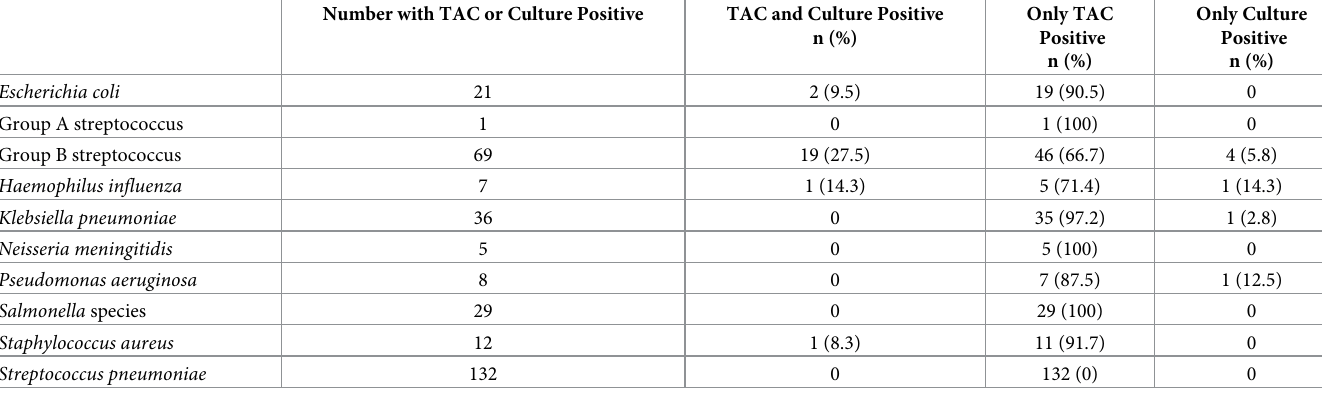
Table 4. Concordance between blood culture and Taqman Array Card (TAC) for detecting bacteria in neonates with early-onset sepsis † . Number with TAC or Culture